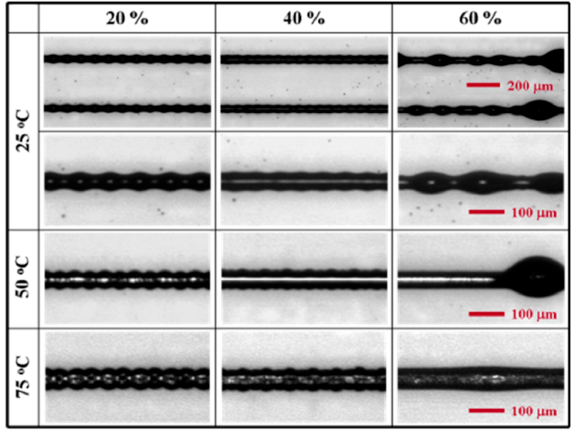
Figure 11. Microscopic images of inkjet-printed lines with 200 Hz printing frequency on S 50 substrate for various droplet overlaps and substrate temperatures when using interlacing printing procedure.